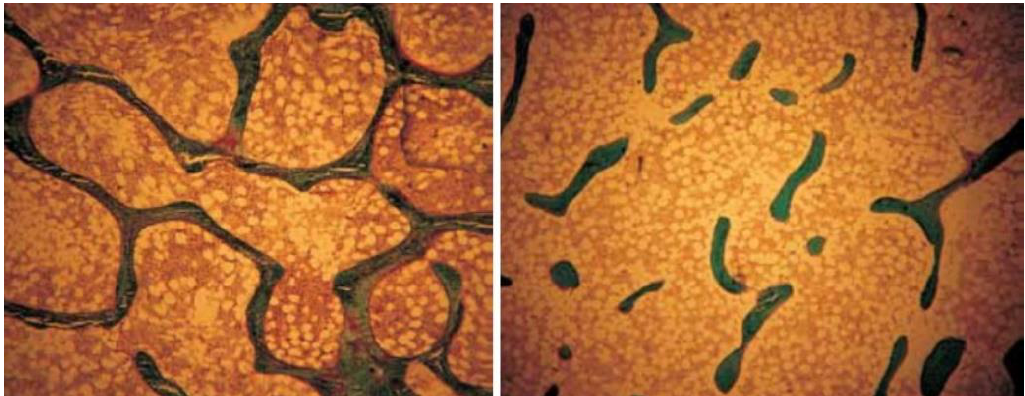
Figure 8. Histomorphometric images of a portion of trabecular bone of a healthy postmenopausal woman ( left ) and of a woman affected by postmenopausal osteoporosis ( right ) [51]. The reduction in the trabecular bone volume is evident. This image is licensed under a Creative Commons Attribution–Non-Commercial 4.0 International